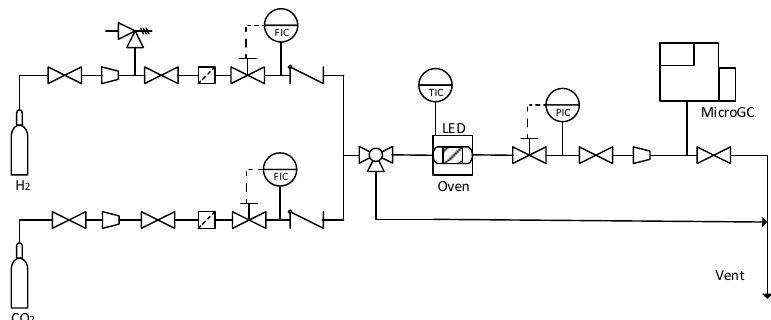
Figure 2. Carbon dioxide hydrogenation experimental plant.